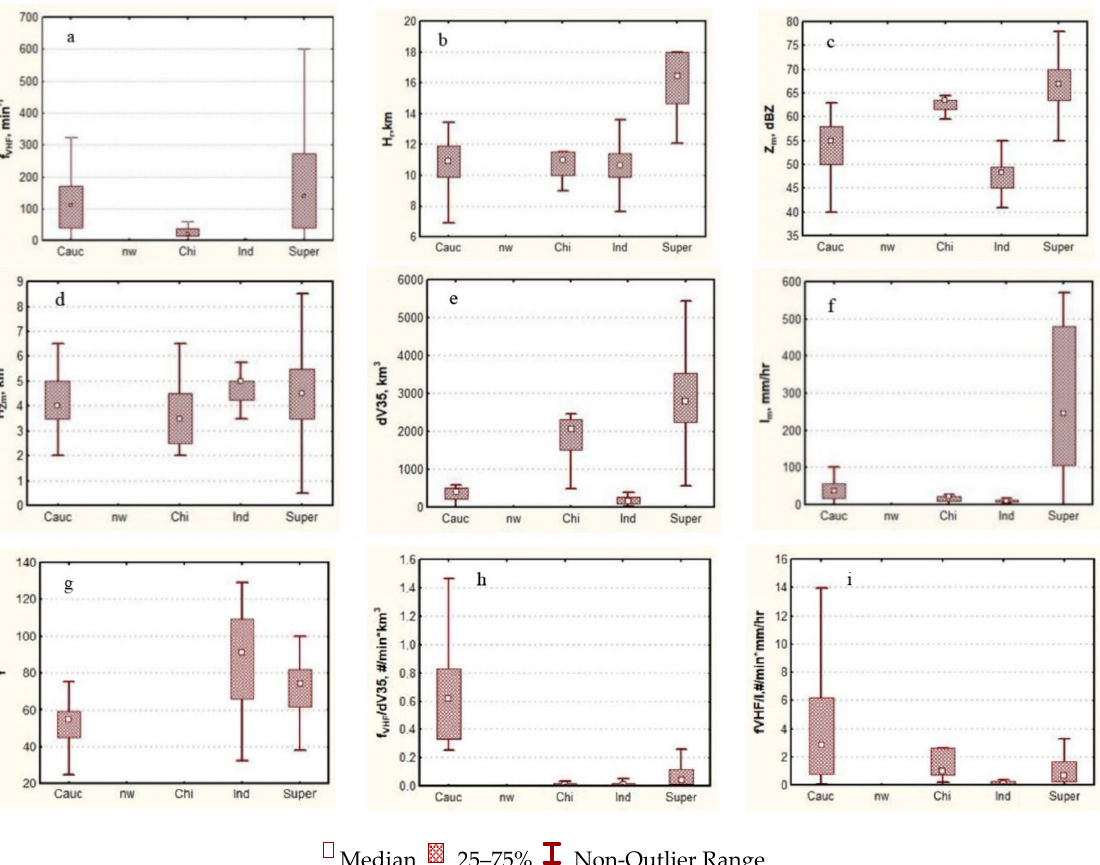
Figure 4. Box-and-whisker diagrams for storms observed when lightning was detected by VHF networks. Characteristics: ( a ) the frequency of lightning strikes f VHF (min − 1 ); ( b ) the cloud top height H r (km); ( c ) the maximum reflectivity Z m (dBZ); ( d ) the Z m height H Zm (km); ( e ) the volume dV35 (km 3 ) above the zero-degree isotherm with the reflectivity higher than the reflectivity threshold of 35 dBZ; ( f ) maximum precipitation intensity I m (mm/h); ( g ) thundercloud criteria Y; ( h ) relationship of lightning frequency to dV35 and I m (f LF /dV35(min − 1 /km 3 ; and ( i ) f LF /I m (min − 1 /mm/h)). The abscissa axis: north Caucasus (Cauc), northwestern Russia (nw); China (Chi); India (Ind); and supercell Cb observed in the north Caucasus (Super).